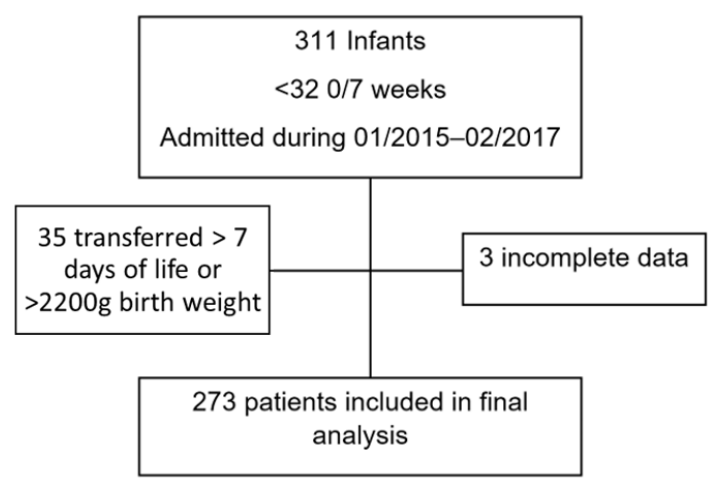
Figure 1. Study population.